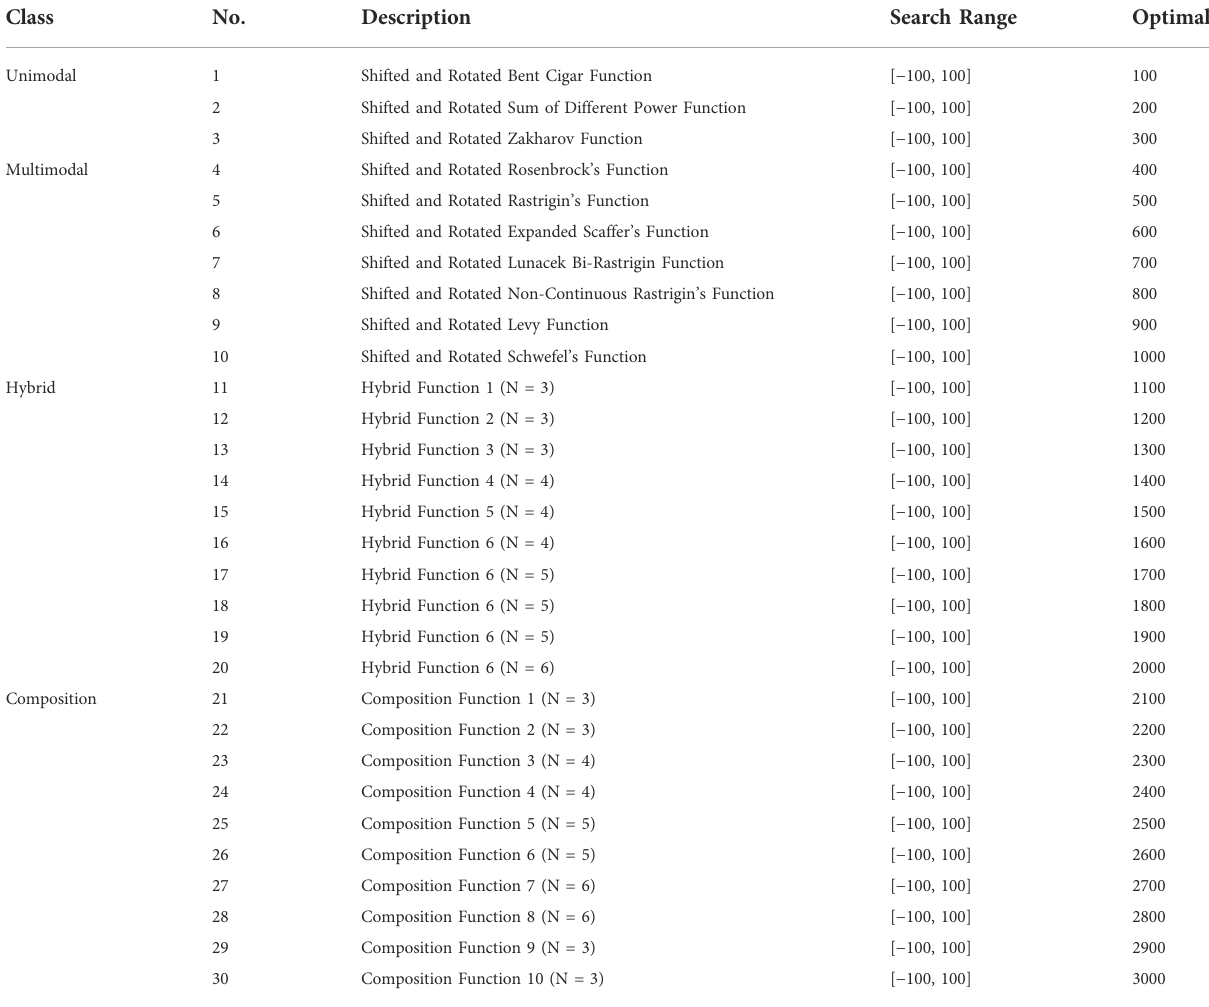
TABLE 8 Summary of the 30 CEC 2017 benchmark